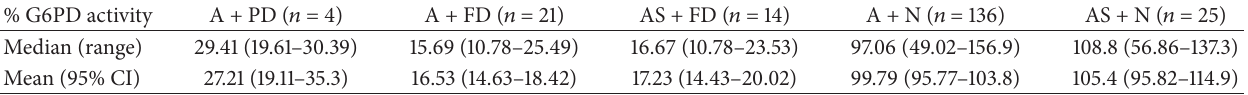
Table 5: % G6PD enzyme activity calculated from the adjusted male median of study participants.